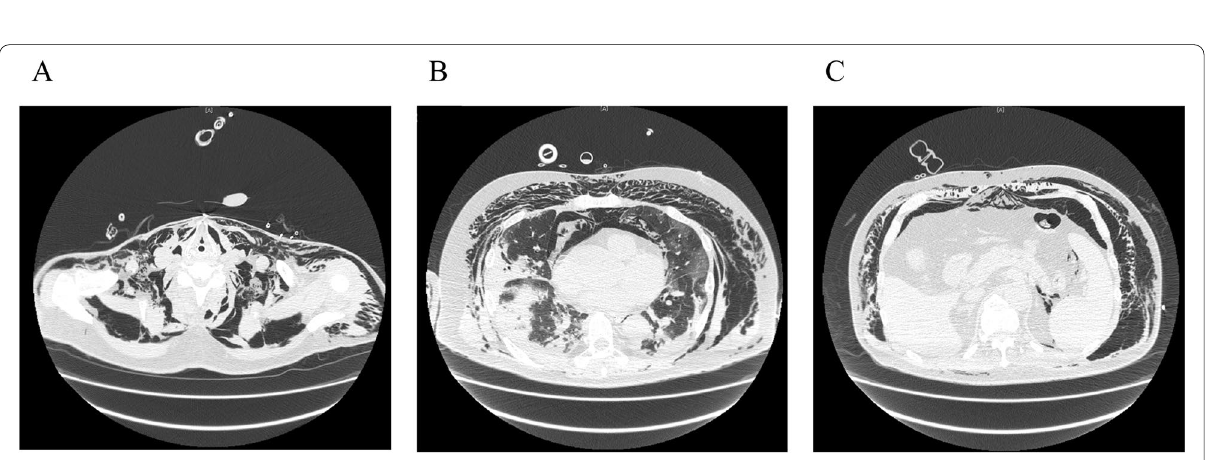
Fig. 1 Chest CT on admission. A At the level of the neck. B Lung bases. C At the level of the pancreas. These images show bilateral diffuse ground-glass opacity with extensive basal consolidation and extensive pneumomediastinum/subcutaneous emphysema from the neck to